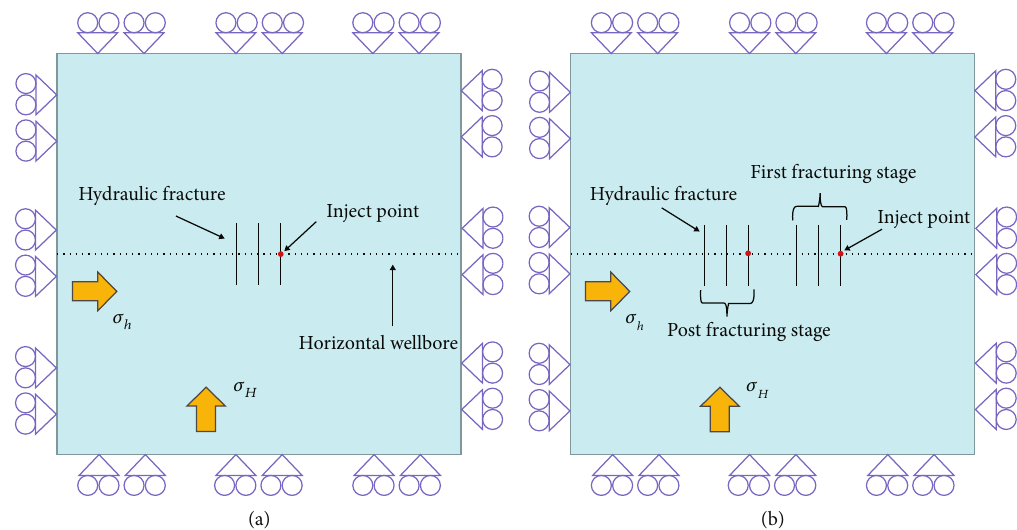
Figure 3: Schematic diagram of horizontal well and fracture: (a) fracturing with only one stage and (b) two-stage